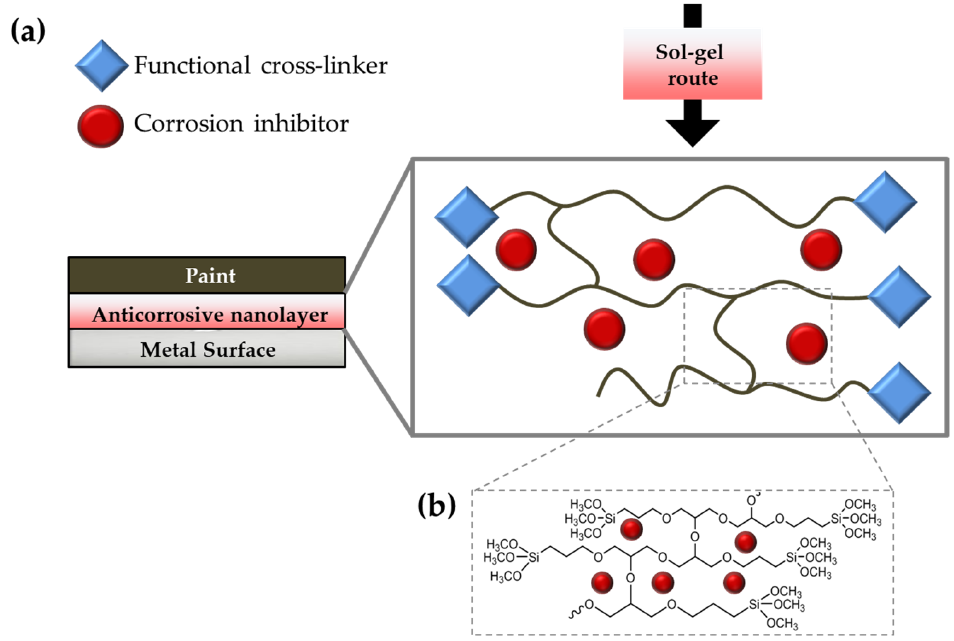
Figure 2. Cross-linking behavior schematization of the functional alkoxysilanes with the presence of the anticorrosive nanofillers ( a ) and detail of the GPTMS cross-linking reaction ( b